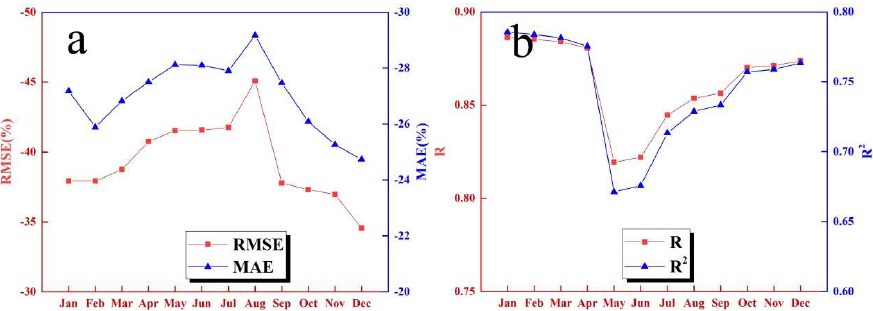
Figure 13. Monthly variations of the statistical indicators representing the model accuracy for the estimated ARFB values at AERONET stations during 2002–2014 ( a for CARSNET stations, b for AERONET stations).